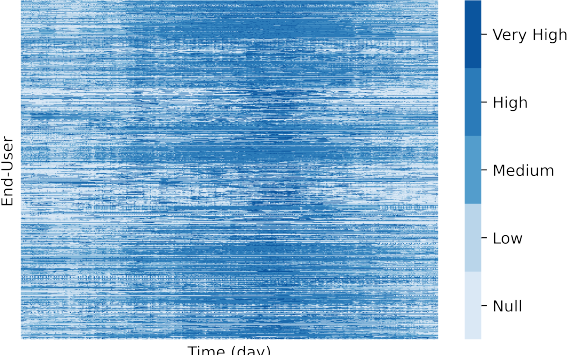
Figure 15. Discretized daily flow rates at InfraQuinta, 2017.